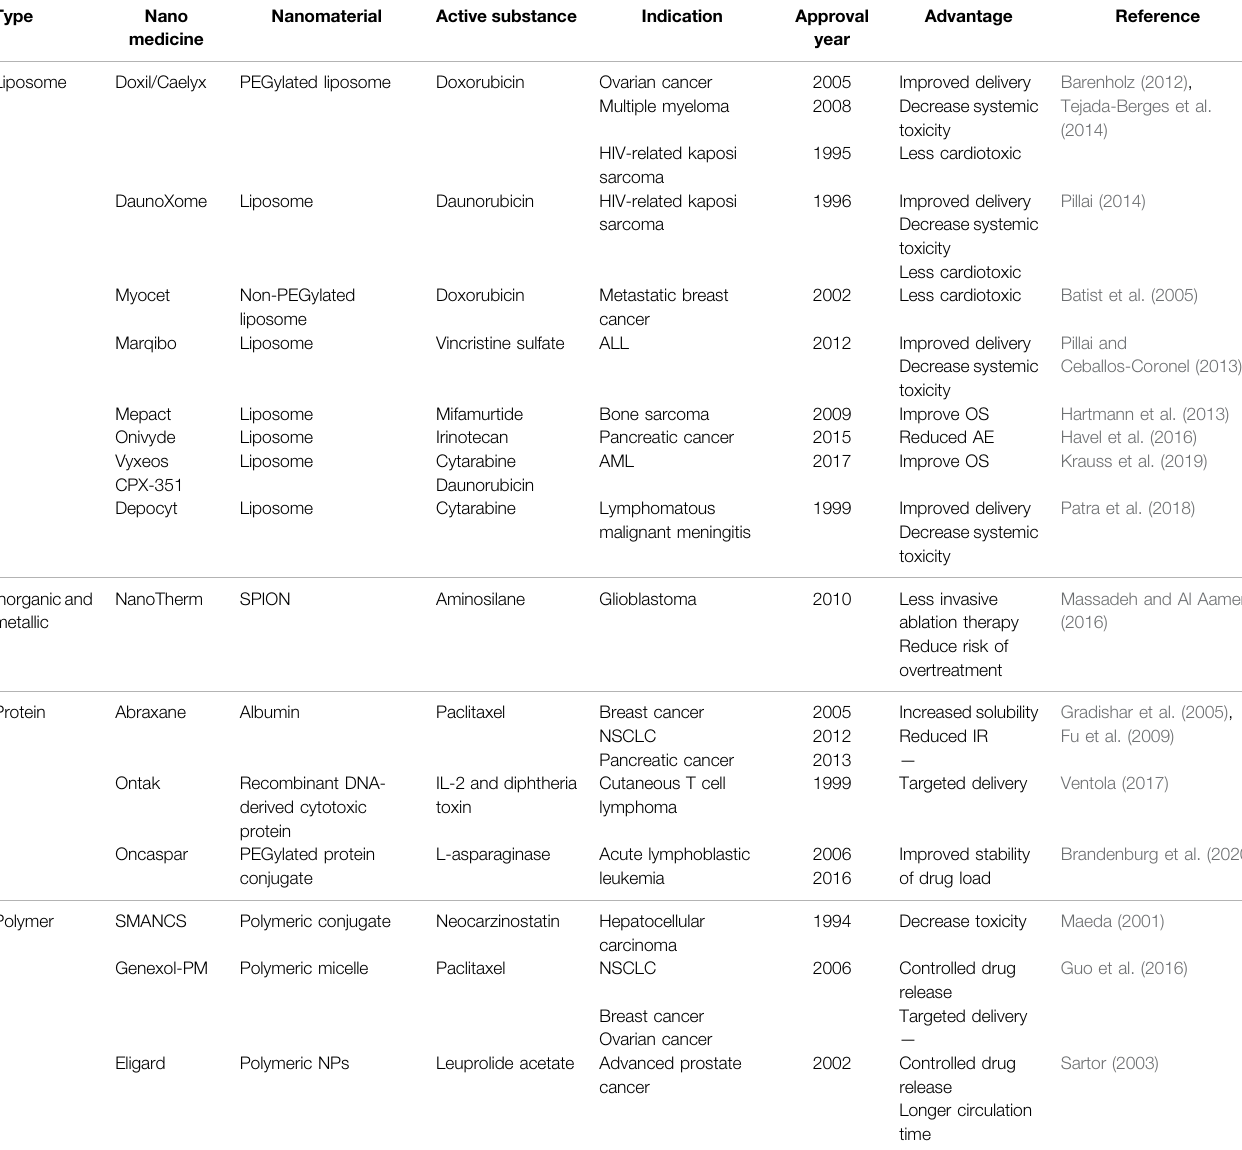
TABLE 1 | Approved nanomedicine in cancer.